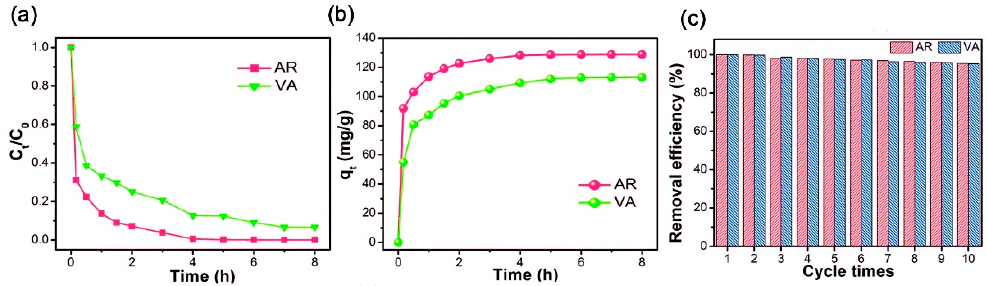
Figure 13. ( a ) Removal efficiency and ( b ) adsorption kinetic curves toward AR and VA by PAN@MIL-100 (Fe)filter. ( c ) Adsorption-desorption cycles. Reproduced and adapted from Ref. [59]; Copyright (2019), RSC Journal of Materials Chemistry A.